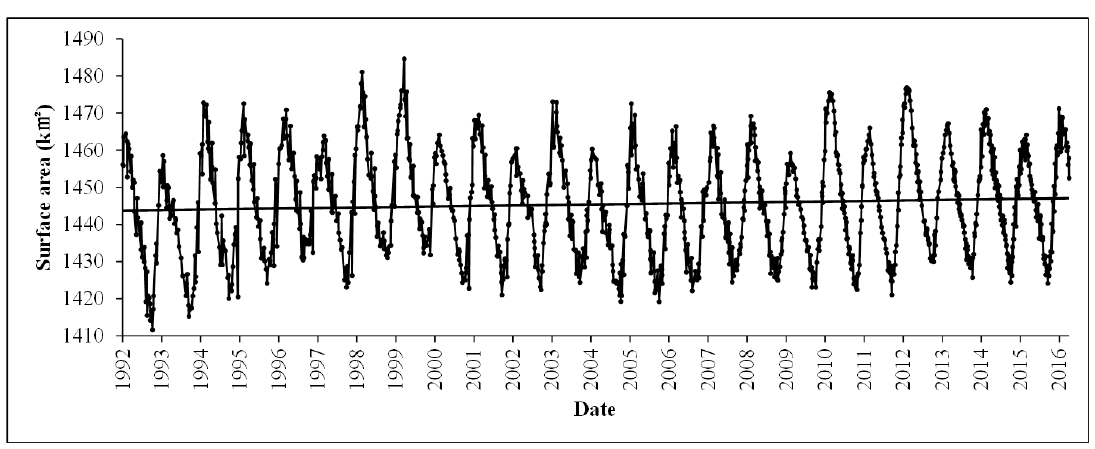
Figure 12. The water level-surface area ( L-A ) curve retrieved for the SPLC ( a ); and its accuracy for lake surface area estimates ( b ).